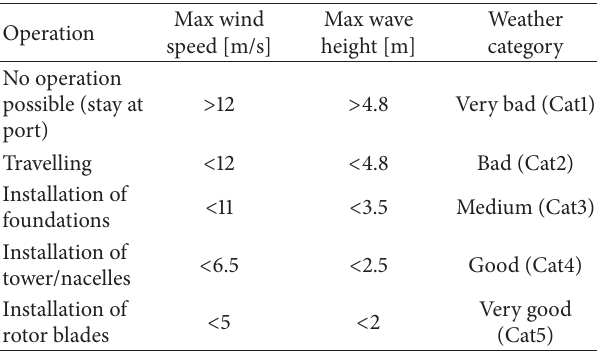
Table 2: Weather classification for each possible